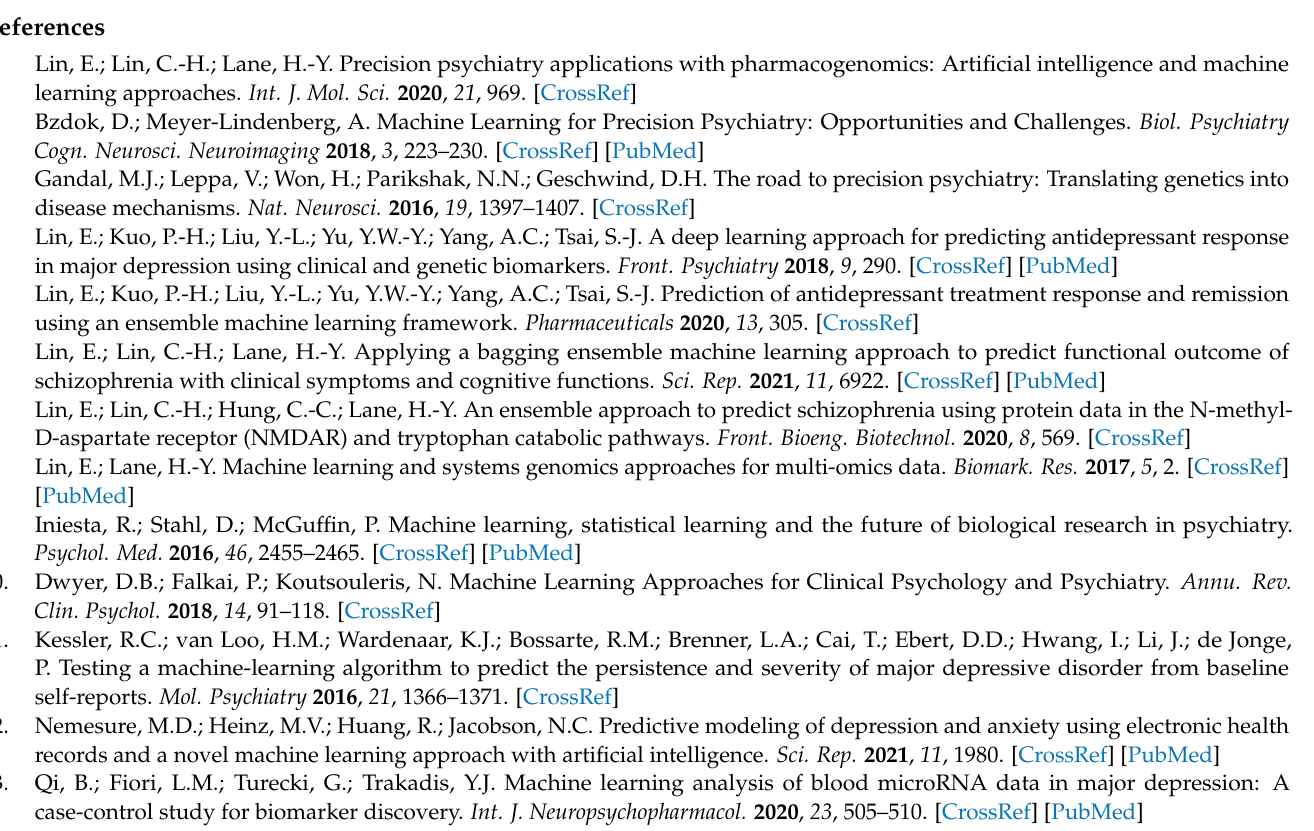
synthetic minority oversampling, Table S1: Odds ratio analysis with odds ratios after adjustment for covariates between MDD and rs193922209 in FBN1 , Table S2: Genotyping results for rs193922209 in FBN1 , Table S3: Odds ratio analysis with odds ratios after adjustment for covariates between female MDD and rs114542799 in ALDH1L1 , Table S4: Genotyping results for rs114542799 in ALDH1L1 , Table S5: Genotyping results for 17 eQTL SNPs, Table S6: The eQTL roles of the 17 eQTL SNPs, Table S7: Summary of SNPs associated with major depressive disorder in previous reports from the NHGRI-EBI GWAS Catalog, Table S8: Nearby SNPs between the Taiwan Biobank and previous reports from the NHGRI-EBI GWAS